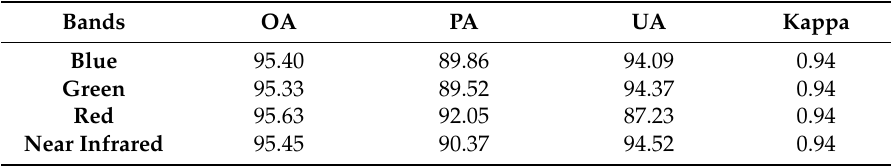
Table 6. The accuracy from combined spectral and textural features of different GF-1